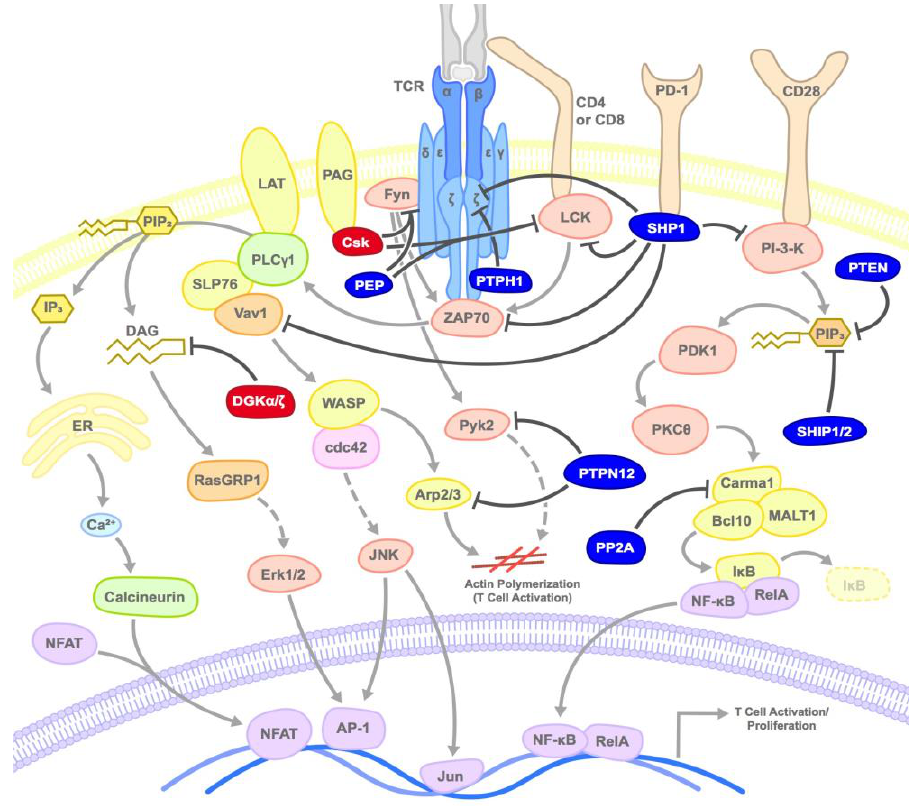
Figure 2. Mode of inhibition of T cell activation by kinases and phosphatases: Kinases or phosphatases inhibit TCR activation at various steps by inducing the phosphorylation or dephosphorylation of various substrates as shown. Dark red circles represent kinases, dark blue circles represent phosphatases, and arrows point to primary target substrates.